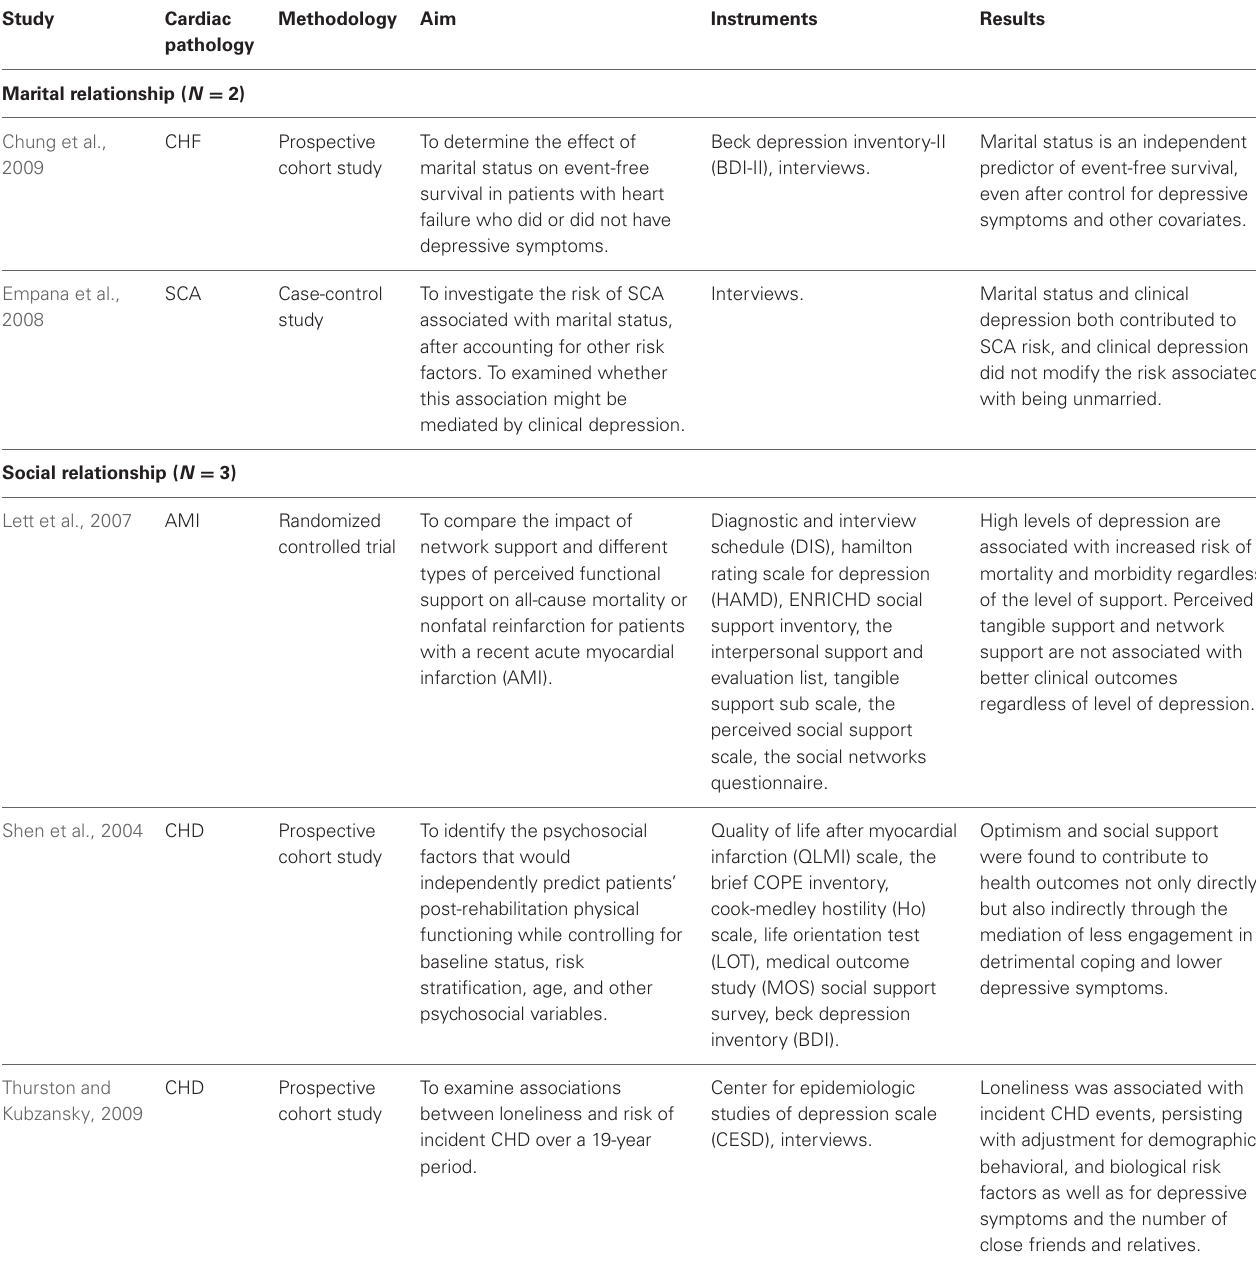
Table 1 | Examined studies concerning the multivariate relationship between depression, social support, and cardiac disease